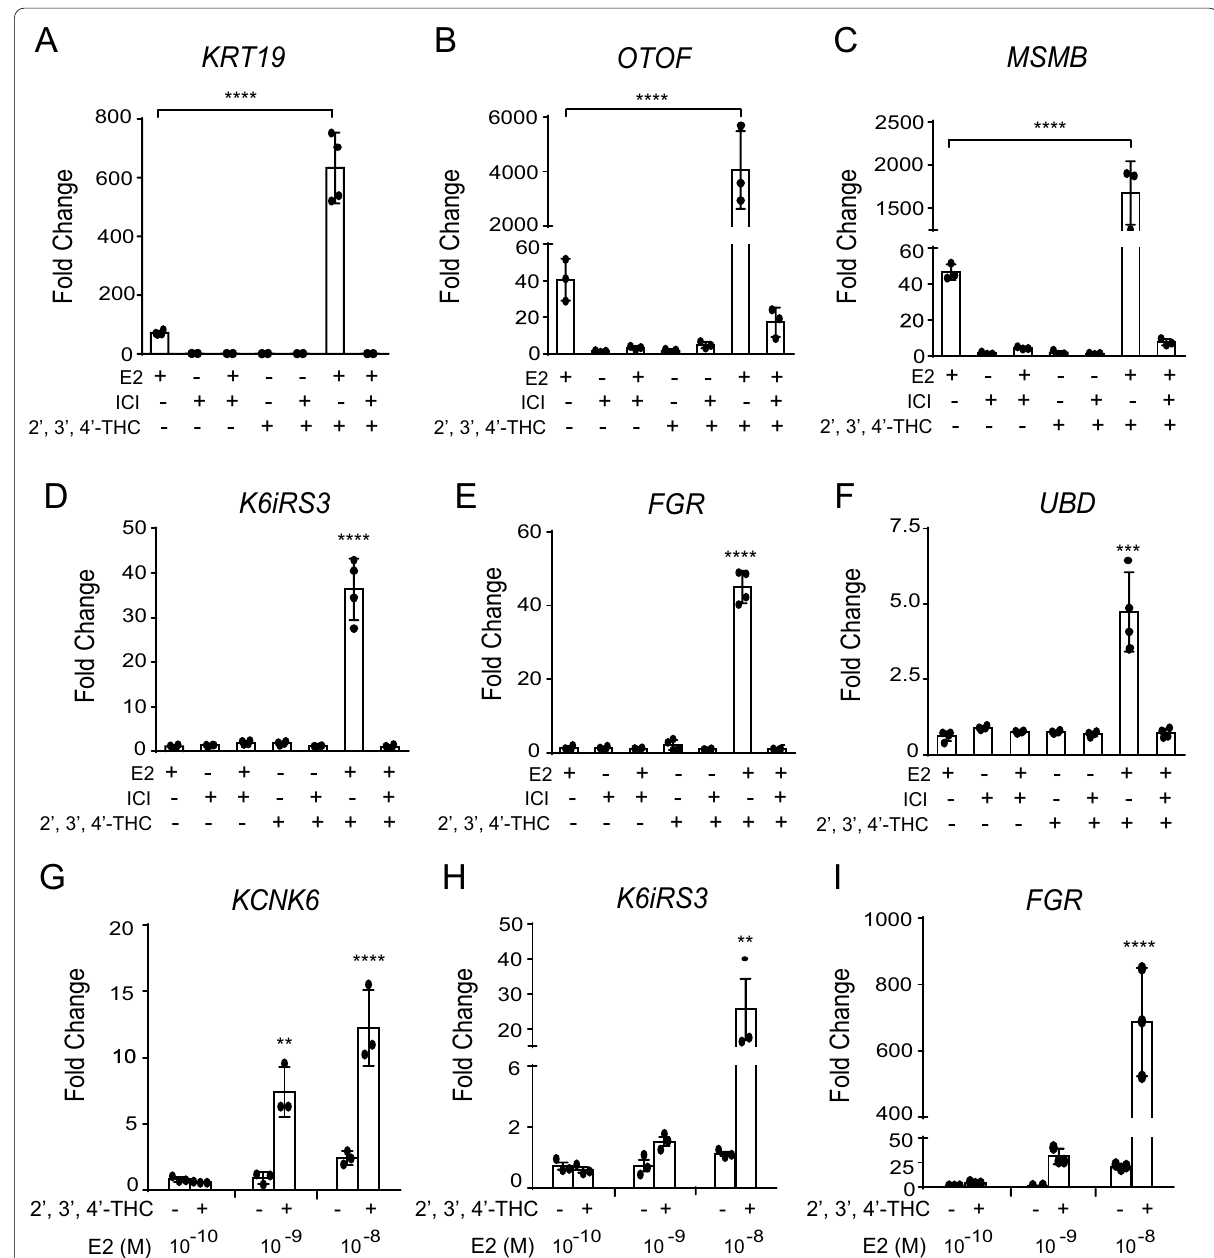
Fig. 3 ICI blocks the 2 ′ ,3 ′ ,4 ′ ‑THC/E2 combination activation of the synergistic and reprogrammed genes. A, B, C Verification of synergistic genes from the microarray in U2OS‑ERα cells treated with 10 nM E2, 5 μM 2 ′ ,3 ′ ,4 ′ ‑THC, and 1 μM ICI alone or in combination for 24 h. A KRT 19 , B OTOF ,